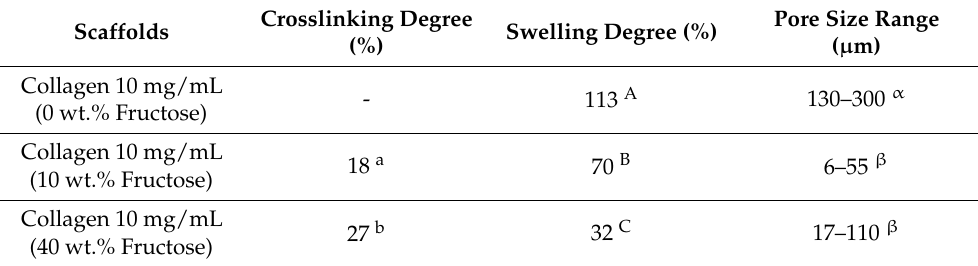
Figure 4. Macrographs and micrographs of 10 mg/mL collagen-based aerogels with different concentrations of fructose: 0 ( A , B ), 10 ( A , B ) and 40 wt% ( C , D ). Table 3. Crosslinking and swelling degrees and pore size range for 10 mg/mL collagen-based aerogels with different concentrations of fructose (0, 10, and 40 wt.%). Different letters as superscripts were included to denote significant differences in the values shown in each column ( p < 0.05).